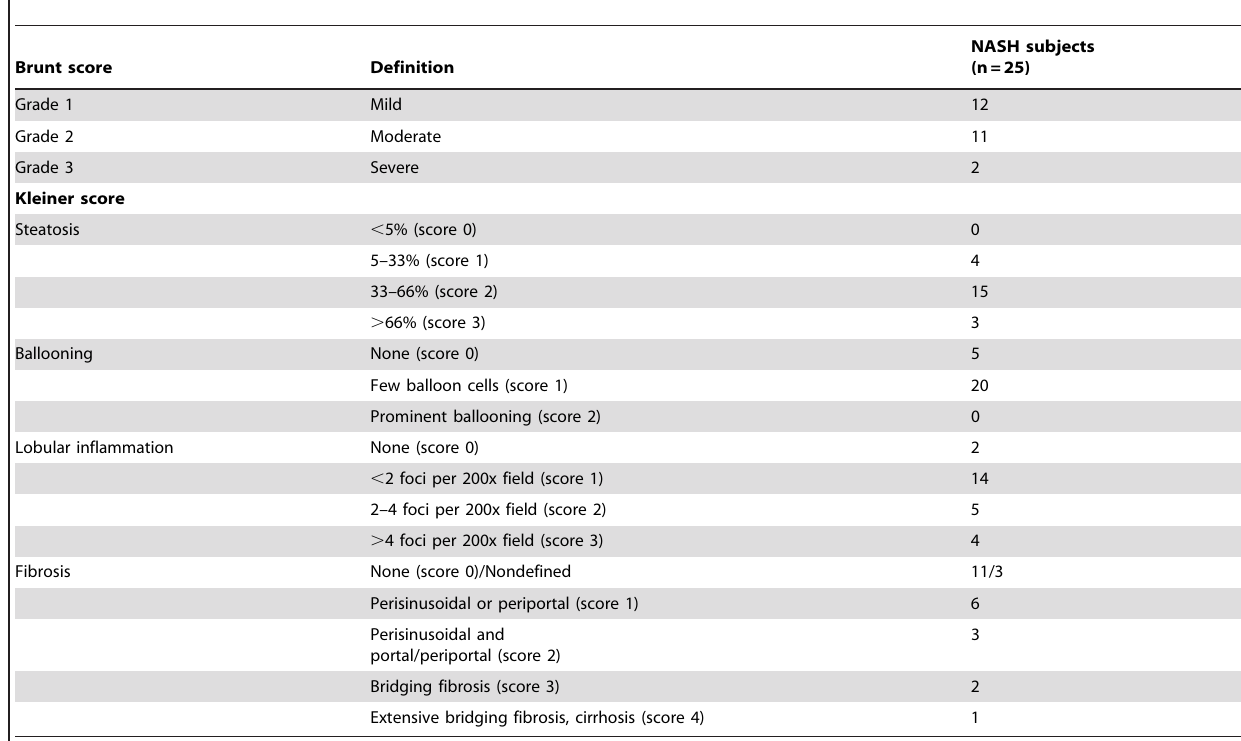
Table 2. Histological scoring of liver biopsies from NASH subjects.